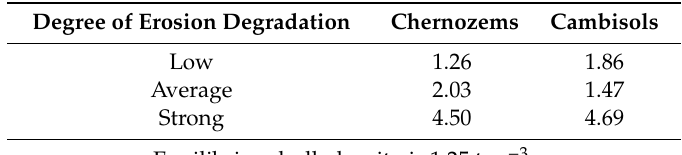
Table 4. The averaged potential estimates of the rate of formation of the humus horizon (t ha − 1 year − 1 ), depending on the degree of soil erosion